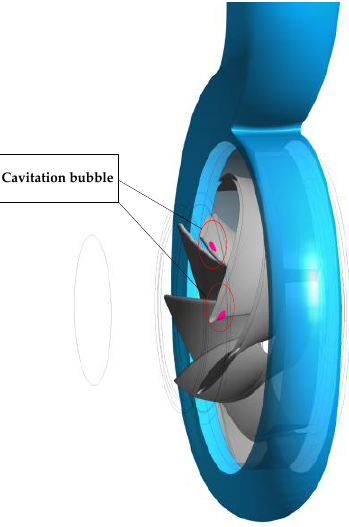
Figure 13. The distributions of cavitation bubbles at 1.22 Q d .